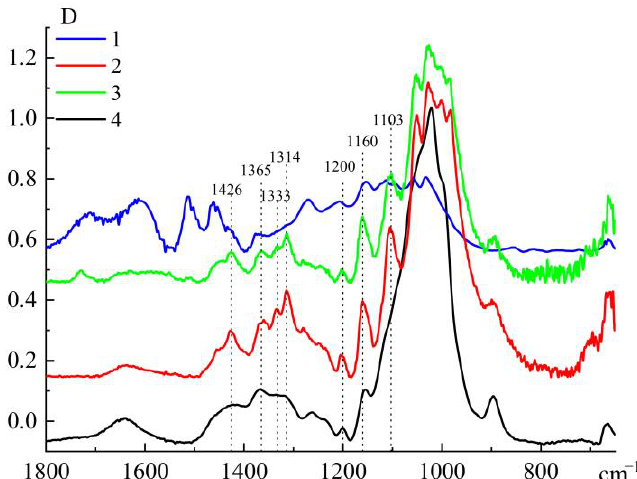
Figure 4. Detailing the spectra of shives (2) and noils (3) with the spectra of lignin (1) and wood cellulose (4).